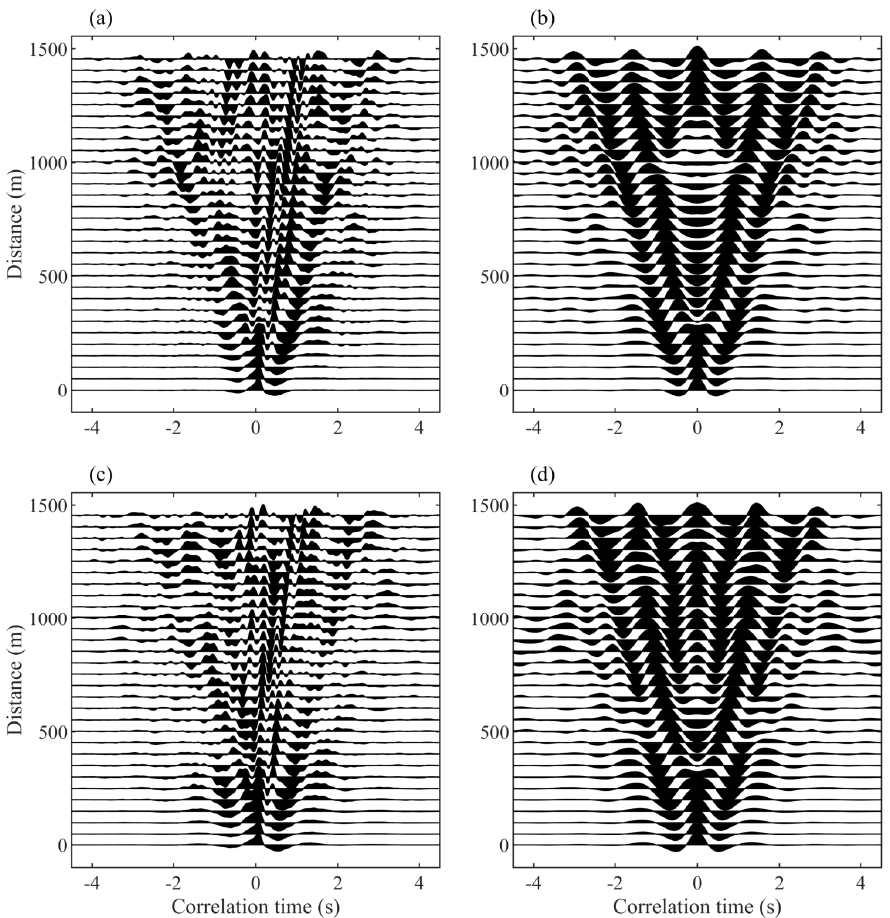
Figure 5. The NCC results. Note that the NCCs are bandpass filtered between 0.2 and 4.5 Hz. ( a , b ) displays the NCC of the gather marked in red in Figure 1; ( c , d ) displays the NCC of the gather marked in green in Figure 1; ( a , c ) displays the NCC retrieved from unfiltered SCM while ( b , d ) displays the NCC retrieved from the filtered